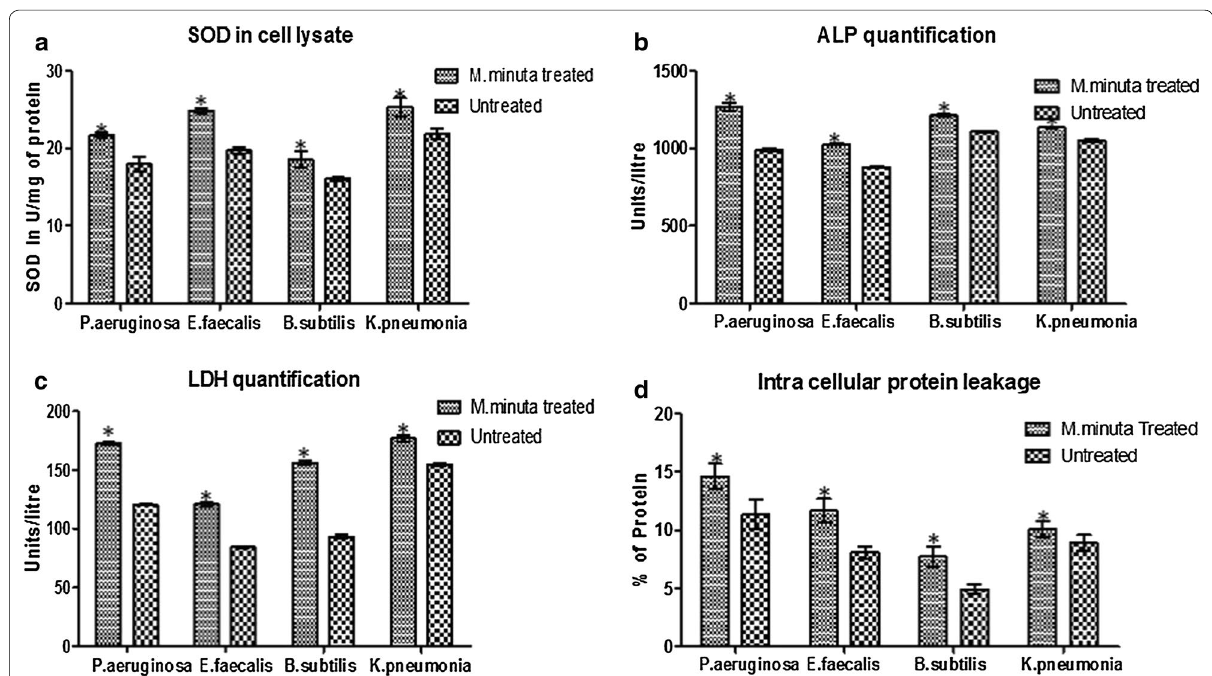
Fig. 2 a Quantification of SOD level in M. minuta leaves extract treated bacterial species; b quantification of ALP level in M. minuta leaves extract treated bacterial species; c quantification of LDH level in M. minuta leaves extract treated bacterial species; d assessment of intracellular protein leakage of bacterial species treated with M. minuta leaves extract. Values represent the mean SEM of triplicate, independent experiments; the ± values labeled with Asterisk indicate statistically significant difference compared with untreated bacteria as determined by Student t-test (p < 0.05)